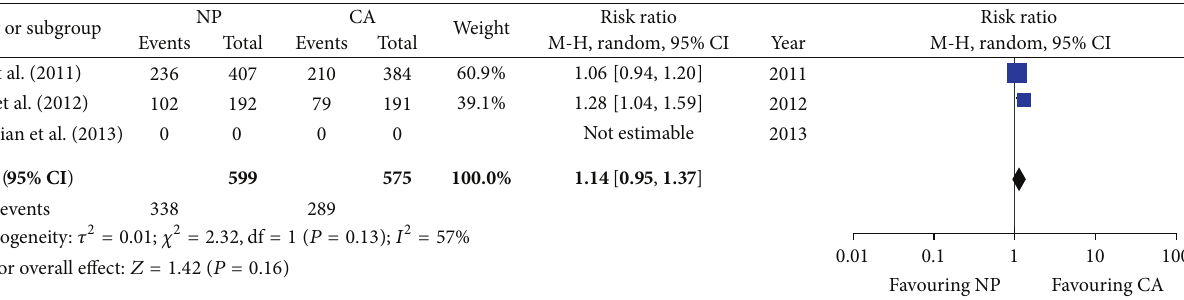
Figure 3: Forest plot on the polyp detection rate comparing NP versus CA. NP: nurse participation in the observation. CA: colonoscopist alone.